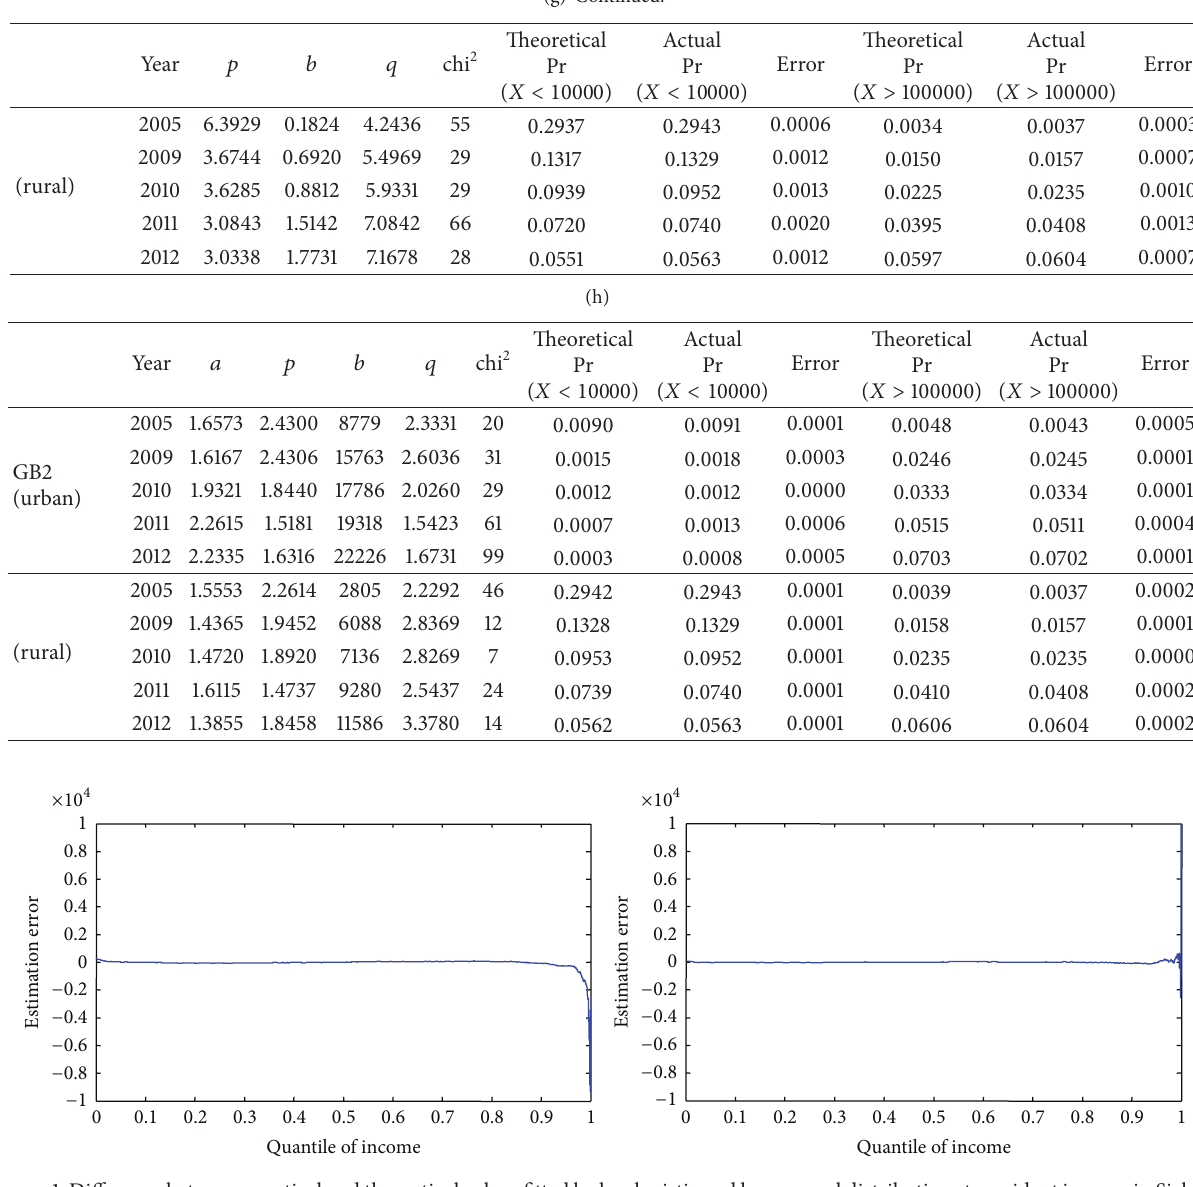
Figure 1: Difference between practical and theoretical values fitted by log-logistic and log-normal distributions to resident income in Sichuan in